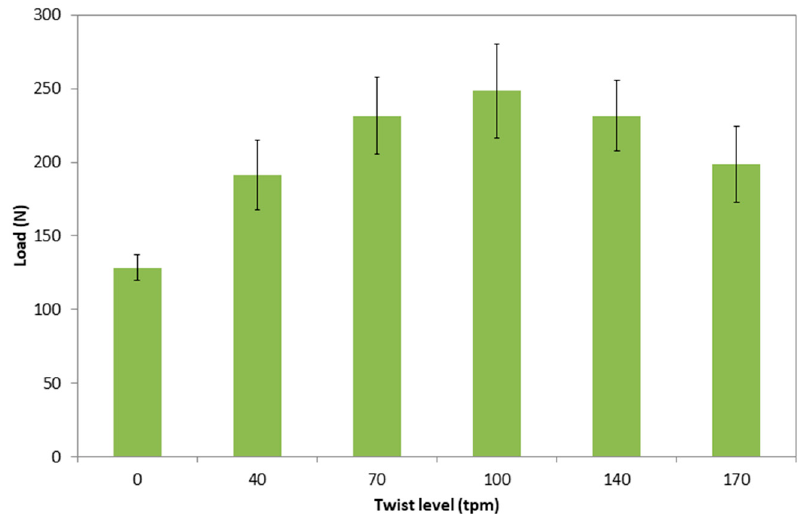
Figure 4. Load at break versus twist level of the flax roving.